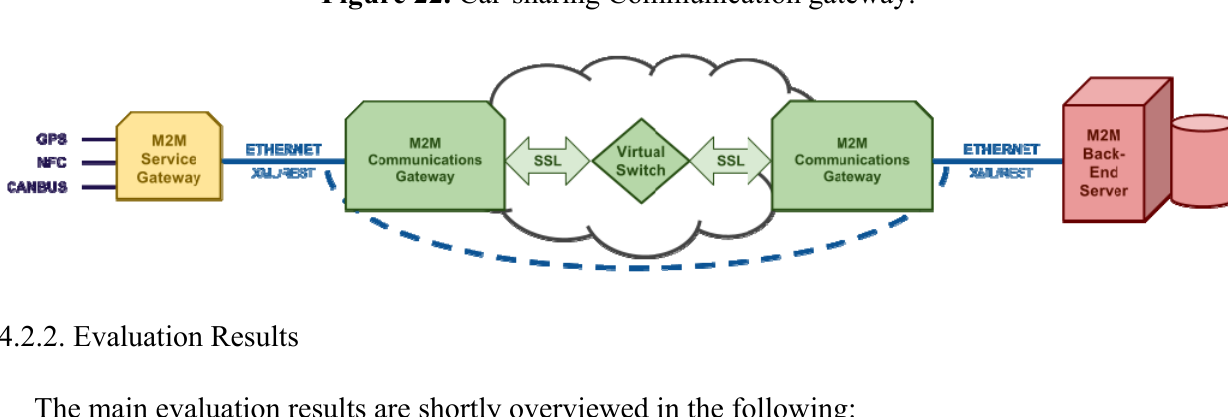
Figure 22. Car-sharing Communication